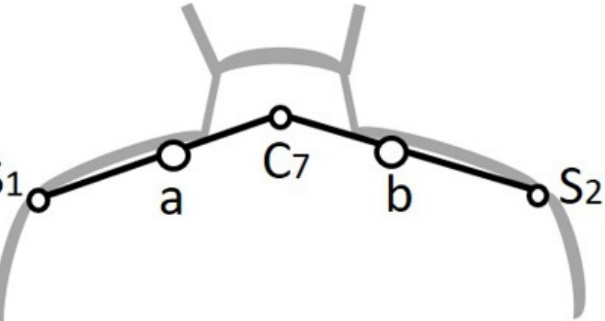
Figure 1. Diagram of the LDF measurement to evaluate shoulder microcirculatory blood flow at point a or b. C7: seventh cervical vertebrae. S 1 and S 2 : acromion of shoulders.